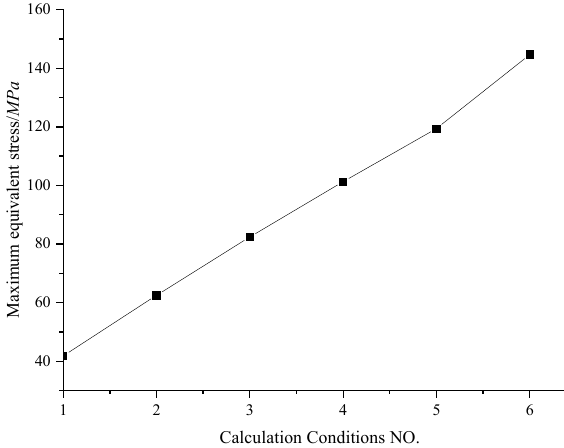
Figure 36. Radial deformation Ux of CR under various calculation conditions in local coordinate system. Figure 37 shows that the maximum equivalent stress of the CR during various tension construction steps gradually increases and finally reaches the maximum value of 144.7 MPa.